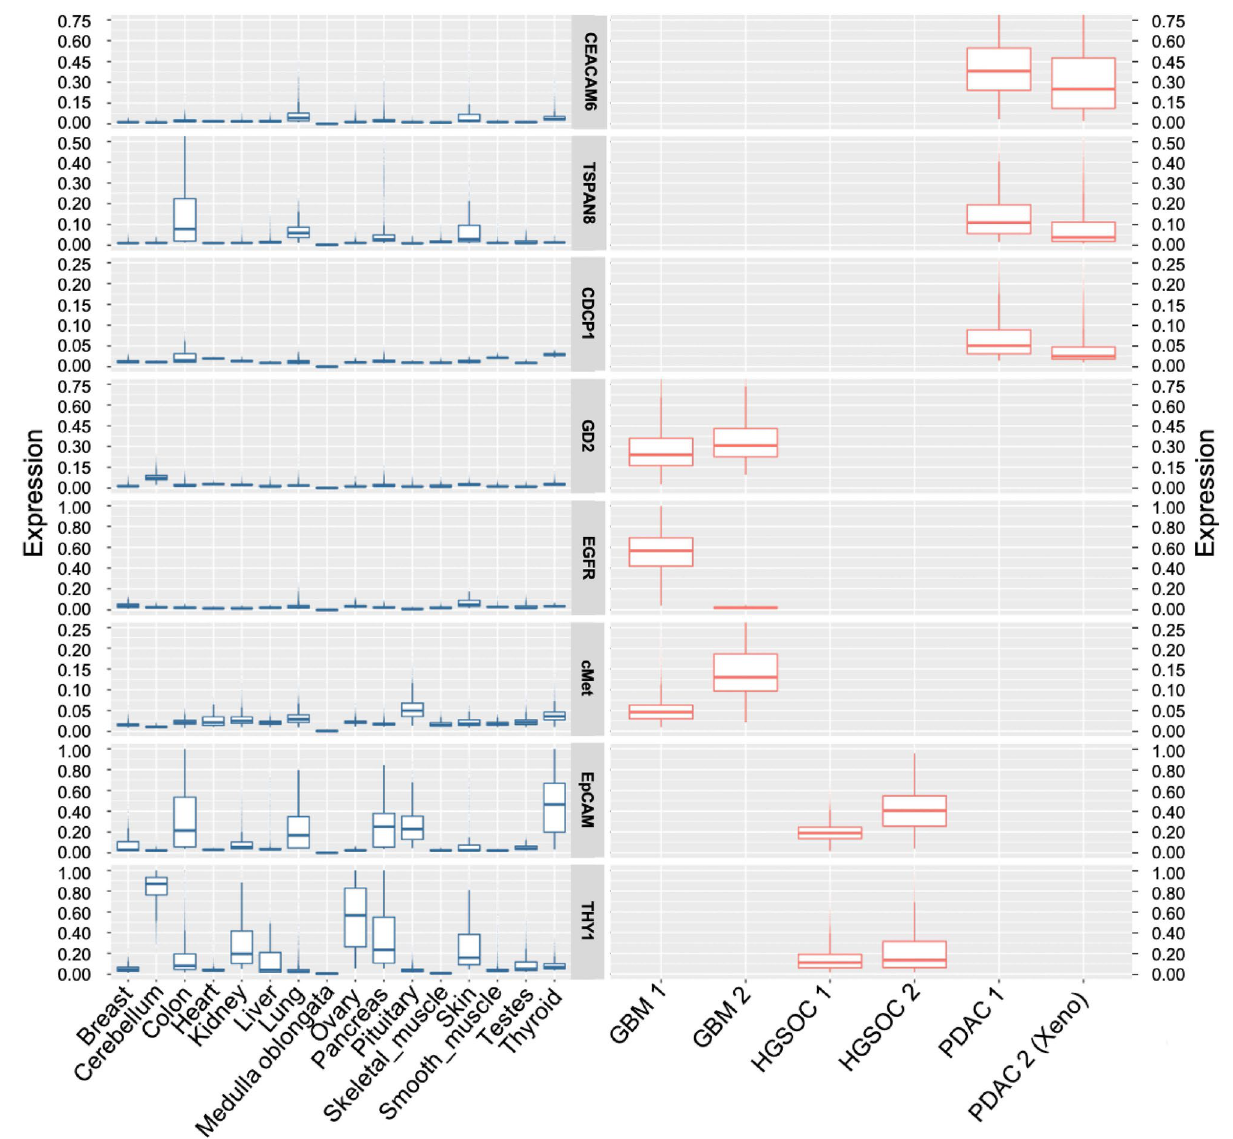
Figure 6. Comparison of marker expression in healthy and cancer samples. Tumor marker expression was quantified on a single-cell level for healthy (left panel) and tumor (right panel) tissue. Image data sets were segmented using MACS iQ View Software based on nuclei and cell membrane markers identifying individual cells. Background-subtracted mean fluorescent intensities (MFI) were computed for each cell and scaled between 0 and 1 for visualization and comparability. Values for all cells detected in one tissue image are displayed as box plots. Note that the scale of expression is kept constant for each marker across all tissues but varies between the markers for optimal representation. The ovarian cancer samples showed a weak but significant positive correlation of 0.35 and 0.20 (significant at α = 0.01; P value = 1.64e−311 and 5.63e−49, respectively) while healthy ovary tissue showed a weak but significant (α = 0.01; P value = 3.89e−107) negative correlation of − 0.23. The marker pair showed comparatively higher positive correlation of 0.58 in healthy breast tissue, but an overall very low expression level. Please note that expression values are only presented for tissues of